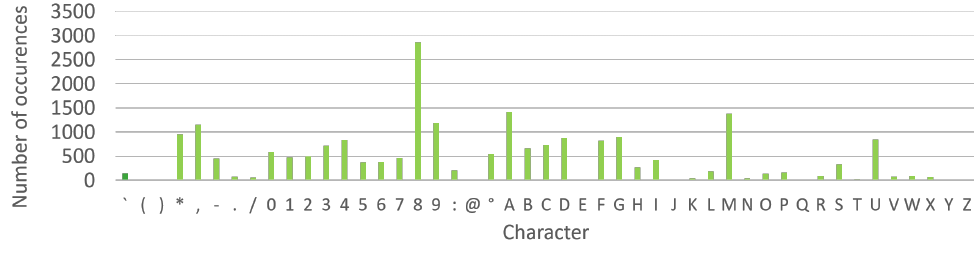
Figure 8. Class distribution of the character recognition